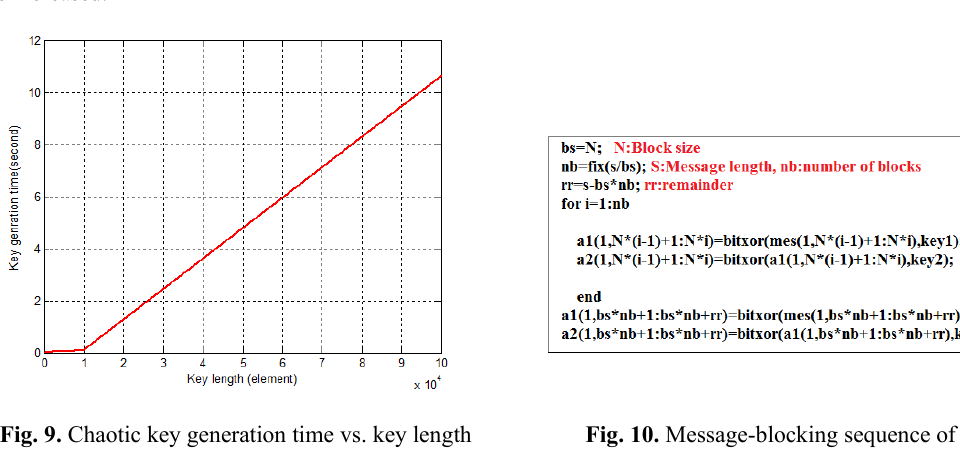
Fig. 9. Chaotic key generation time vs. key length Fig. 10. Message-blocking sequence of operations